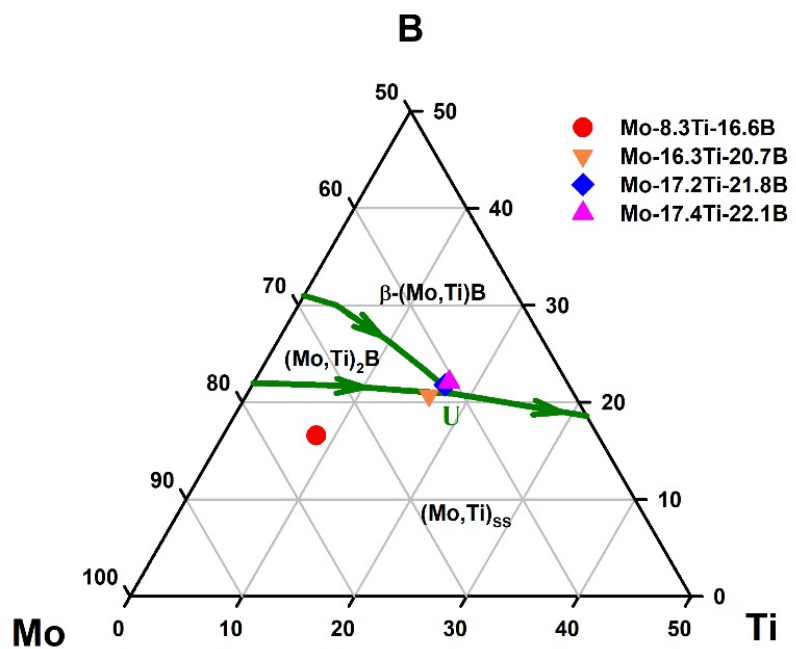
Figure 1. Liquidus projection of the Mo-Ti-B system, data from [14] superimposed with the alloy compositions of the present study.